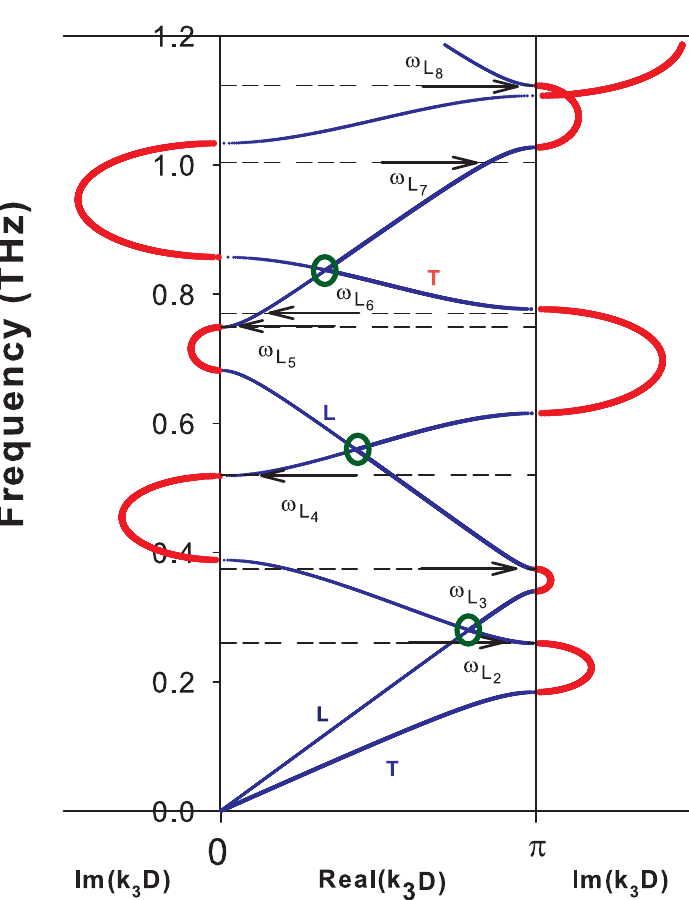
Figure 2. Complex band structure of sagittal modes in an Si-graphene based SL d Si = 11 nm, d G = 0.335 nm, D = d Si + d G and k // D = 0. The blue curves correspond to real k 3 inside the Brillouin zone (between 0 and π / D ). The red curves at the left part of the figure correspond to a purely imaginary k 3 , whereas red curves on the right part of the figure correspond to a complex k 3 when its real part is equal to π / D . L and T refer to pure longitudinal and pure transverse modes, respectively. The horizontal arrows indicate the positions of the frequencies of surface localized modes labeled L i